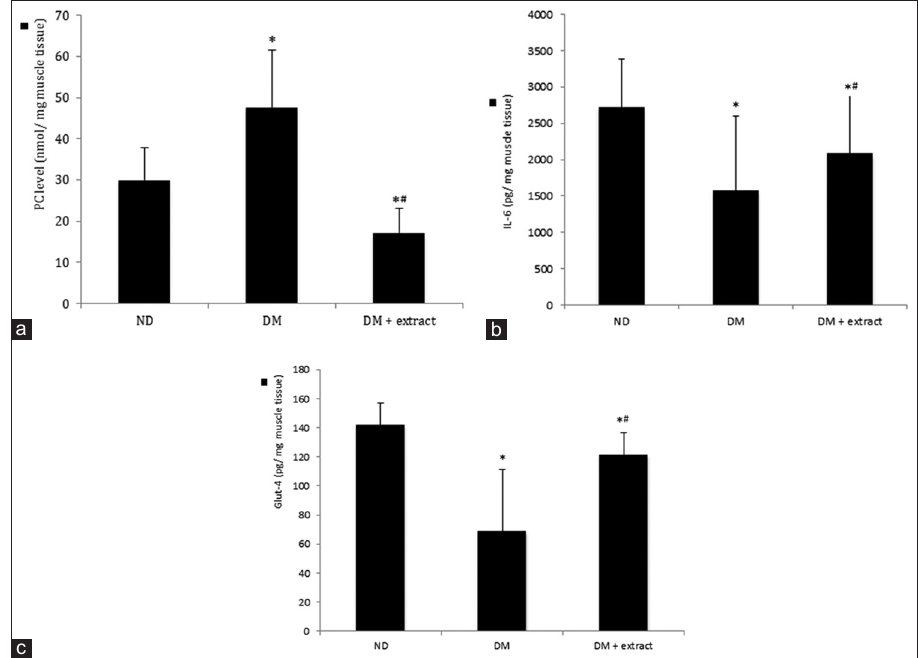
c Figure-1: (a-c) protein carbonyl, interleukin-6, and Glut-4 level in mg gastrocnemius muscle tissue, comparison between groups. ND=Non-diabetes group, DM=Diabetes group, DM+extract=Diabetes extract-treated group. *Mean was significantly different to ND, # Mean was significantly different to DM. Error bar indicates standard error for each group.